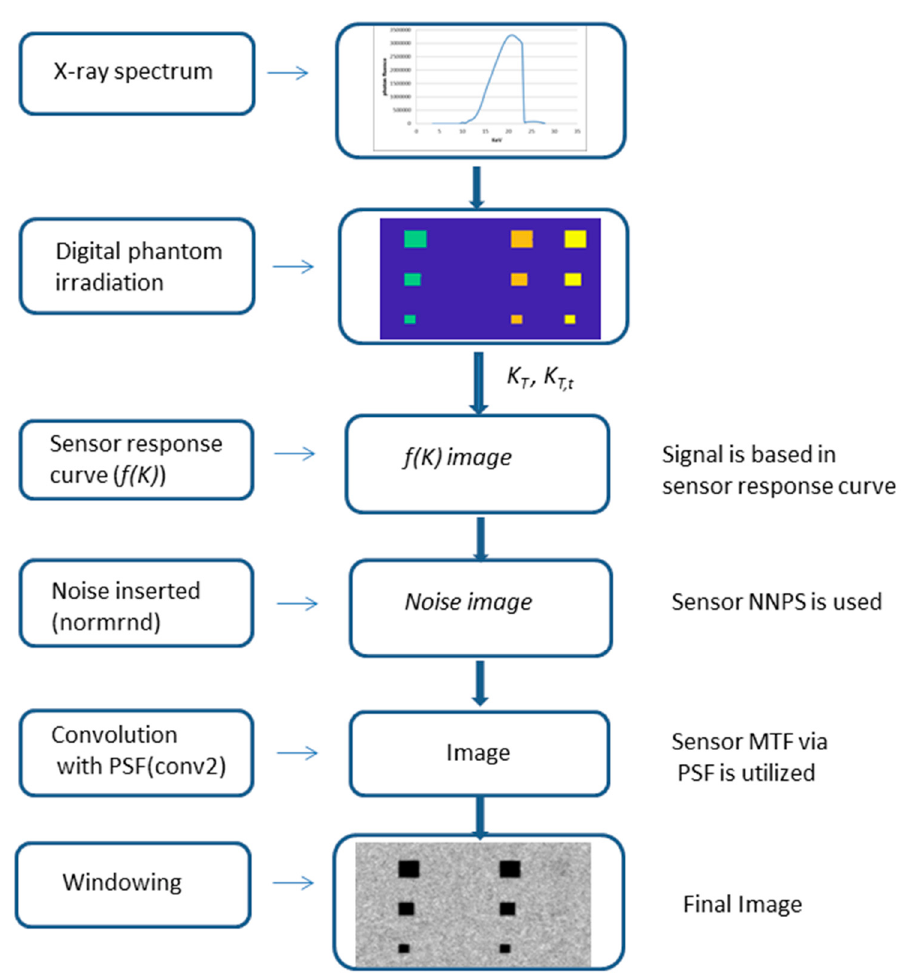
Figure 3. A flowchart of the method described in Equations (1) to (6).